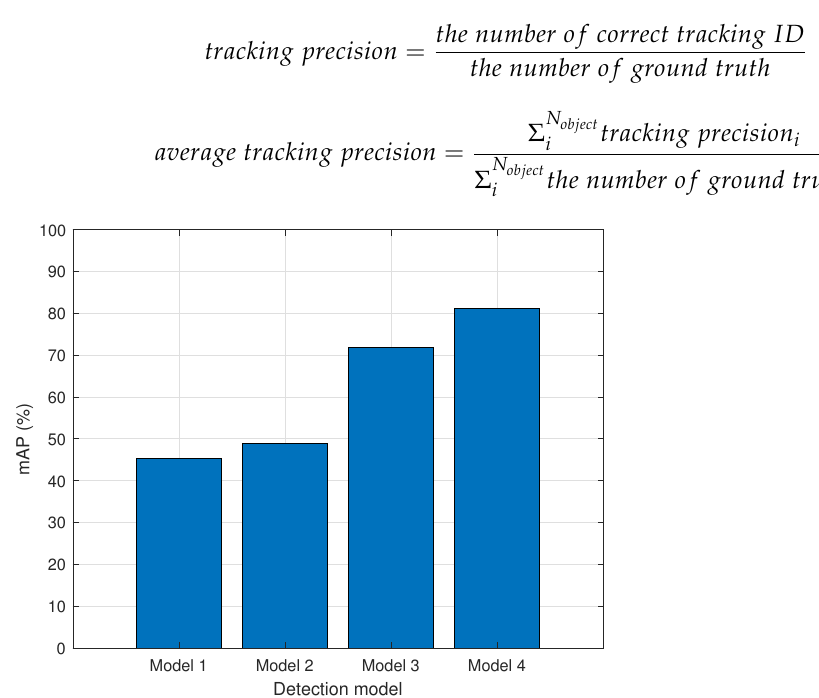
Figure 8. The mAP for each recognition model.